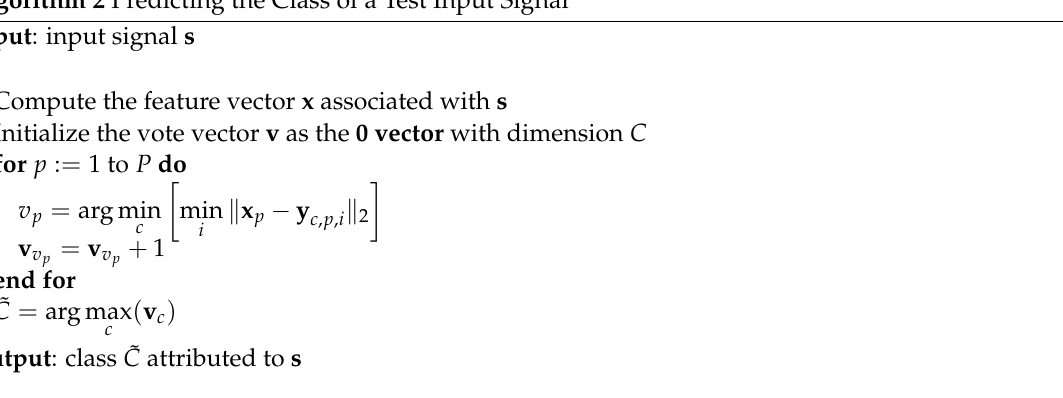
Algorithm 2 Predicting the Class of a Test Input